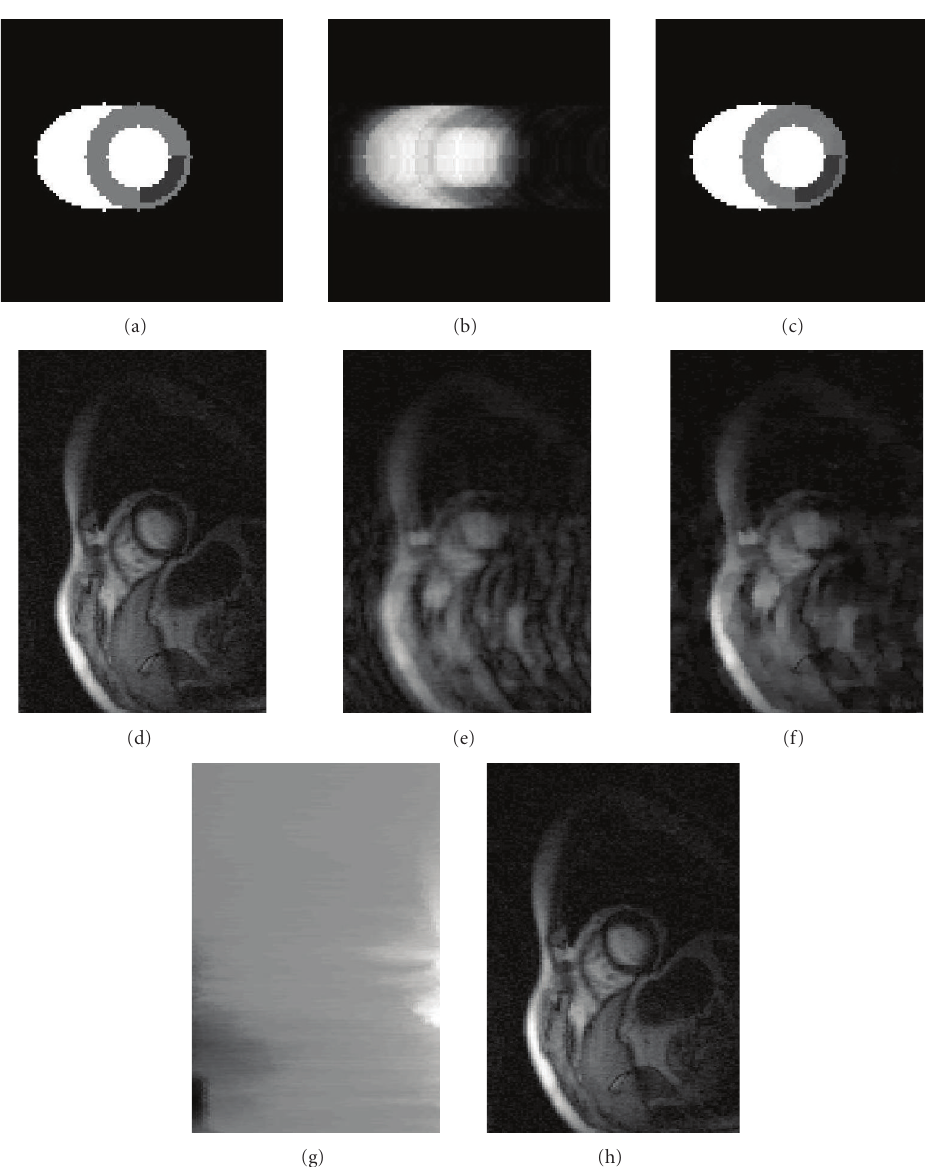
Figure 5: Reordering method for 2D images. (a) Simulated piecewise constant heart image. (b) Image reconstructed using IFT from ∼ 15% of the full Fourier data, undersampled in a variable density random fashion. (c) Image reconstructed from undersampled data using a TV spatial constraint. (d) Actual MR magnitude image of the short-axis slice of a heart at a single point in a perfusion sequence reconstructed from fully sampled k -space data using IFT. (e) Corresponding IFT reconstruction from R ∼ 3 k -space data undersampled in VD random fashion. (f) Reconstruction using a 2D TV constraint without any reordering. (g) Row-reordered image of the real part of the complex MR image of the heart. (h) Reconstructed image with spatial reordering using a TV constraint. Ordering of the data here was obtained using the image reconstructed from fully sampled